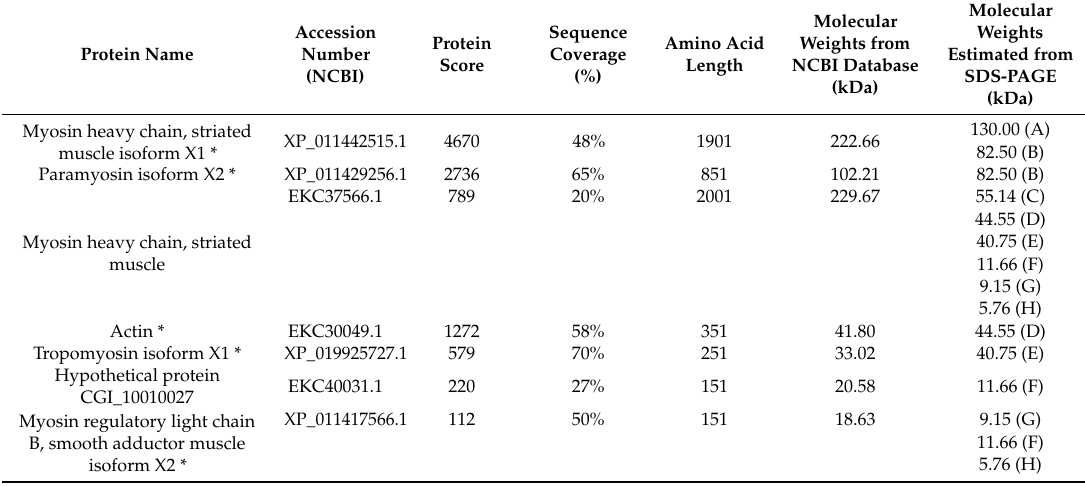
Table 1. Identified proteins from Portuguese oyster ( C. angulata ) meat and their